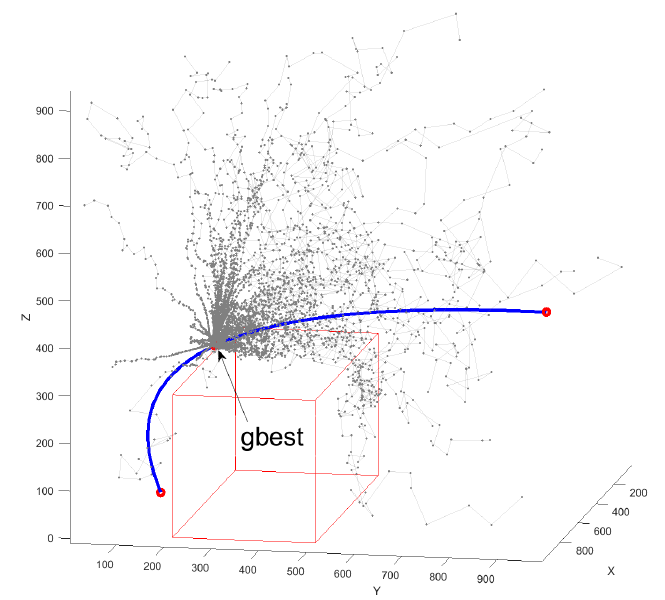
Figure 8. The figure of the best excess point for particle swarm search. The red cube in the figure is the randomly generated obstacle cube, the red dots are the three interpolation points in the trajec- tory, the blue curve is the polynomial interpolation trajectory, and the gray trajectory is the particle swarm search trajectory.